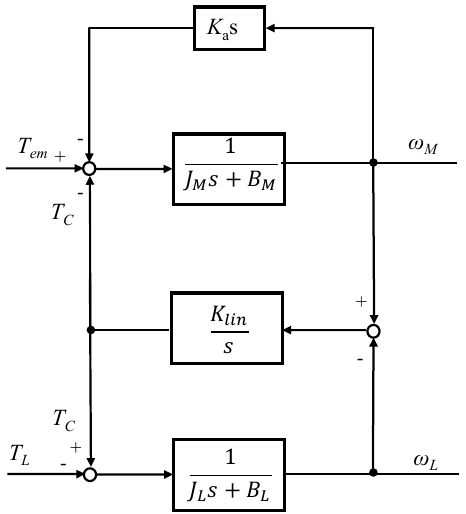
Figure 2. Block diagram of MDTs with acceleration